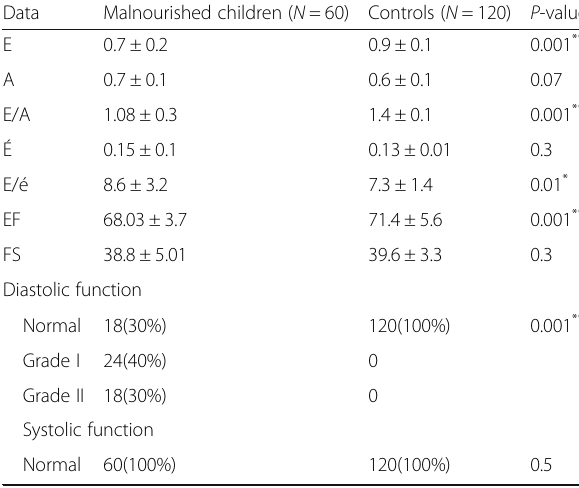
Table 1 Comparison between baseline tissue Doppler findings in studied children (PEM and control group) at admission